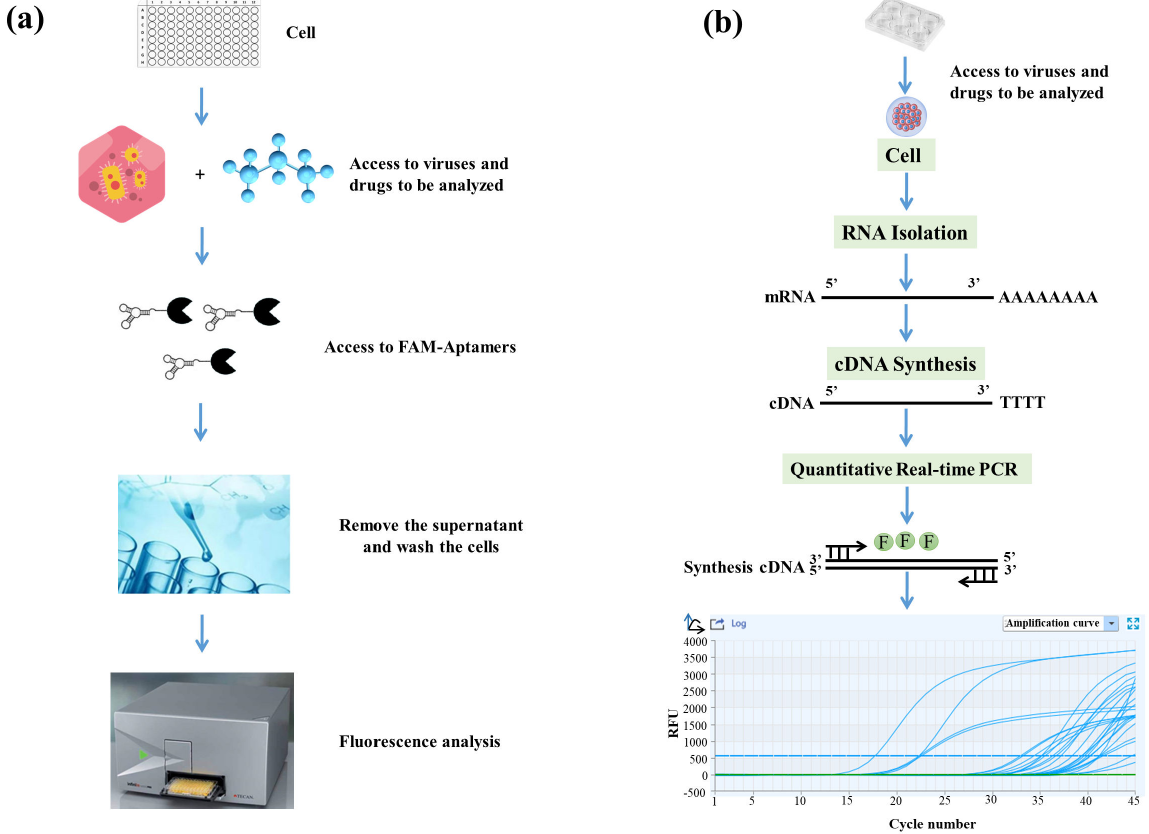
Figure 1. Flow chart of Q2-AHTS and RT-qPCR technology. ( a ) Flow chart of AHTS technology. ( b ) Flow chart of qPCR